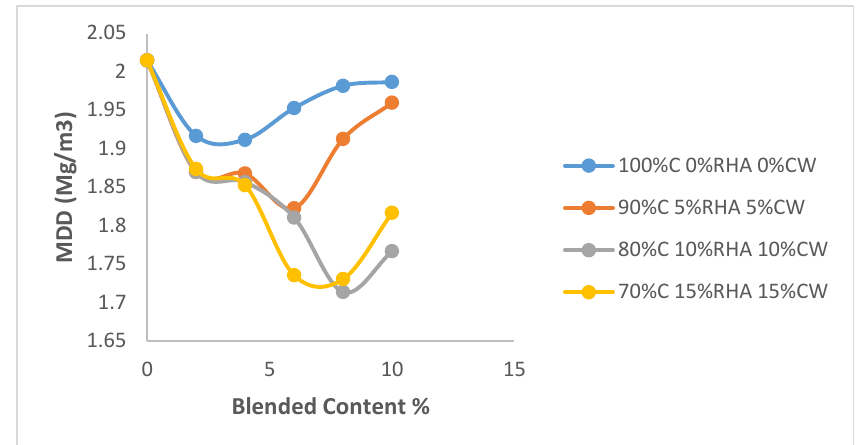
Fig. 6. Relationship between the MDD of laterite treated with (100%C 0%RHA 0%CW), ( 90%C